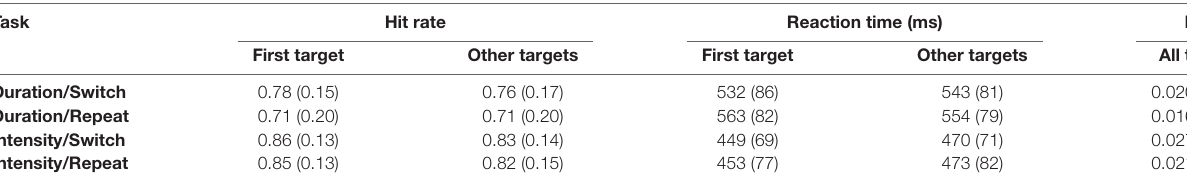
TABLE 1 | Behavioral data.